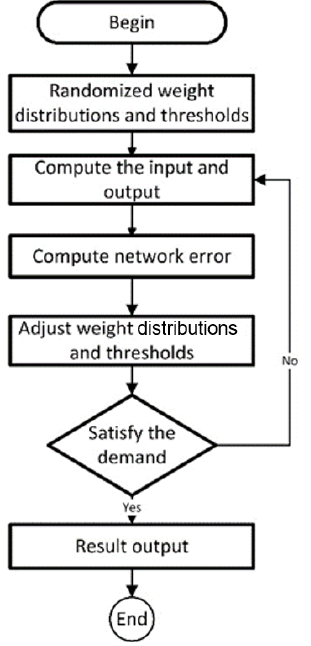
Figure 1. Flowchart of the BP neural network.